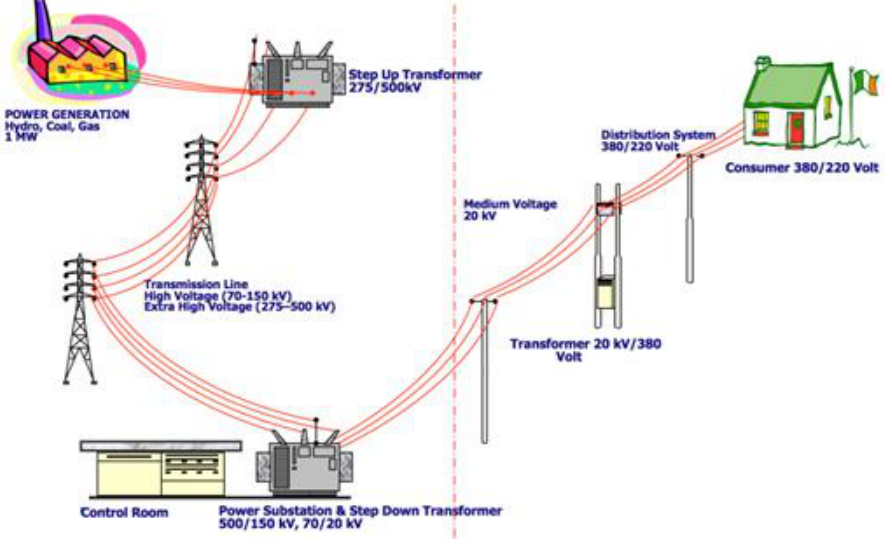
Figure 3. Schematic representation of PLN process architecture [51,52].